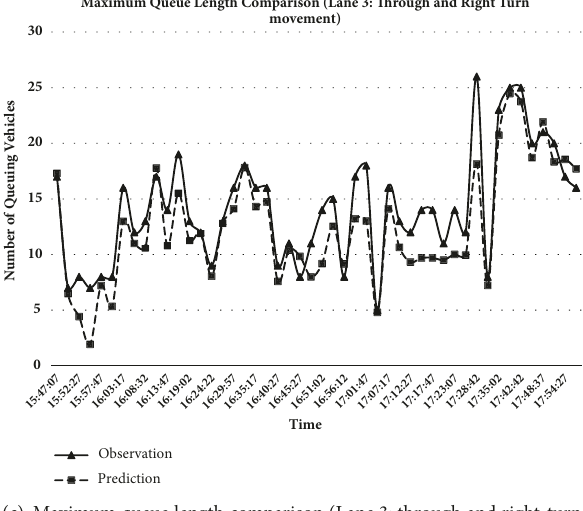
(b) Maximum queue length comparison (Lane 2: through movement)